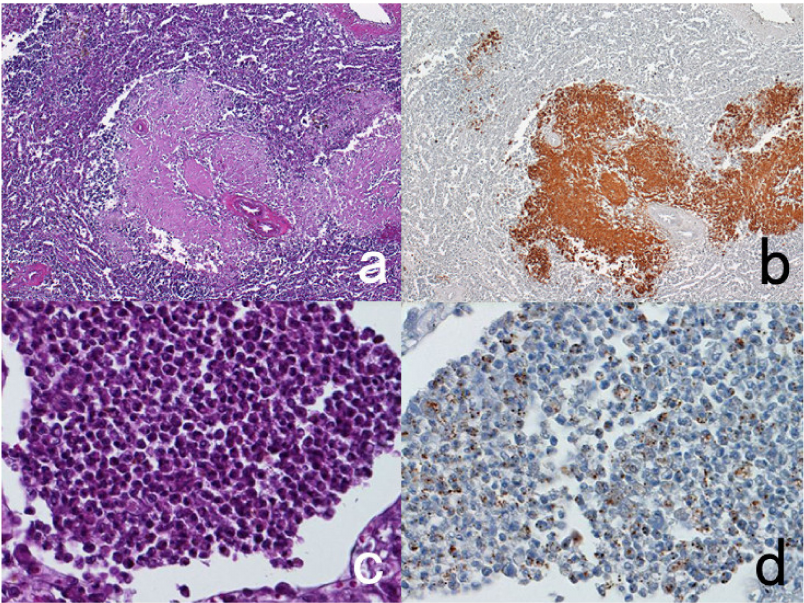
Figure 9. Demonstration of amyloid A in secondary amyloidosis and pneumococcal antigens in lobar pneumonia in archival material. Top panels ( a , b ): Splenic white pulp with amyloid A deposition. Bottom panels ( c , d ): pneumococcal antigens in lobar pneumonia showing diffuse neutrophilic infil- tration. Left ( a , c ): H&E and Right ( b , d ): chromogenic immunostaining. The specimens were fixed in formalin for 70 years. Deposition of amyloid A protein is evident in the splenic white pulp (no pre- treatment needed). Pneumococci phagocytized by neutrophils are visualized immunohistochemically after